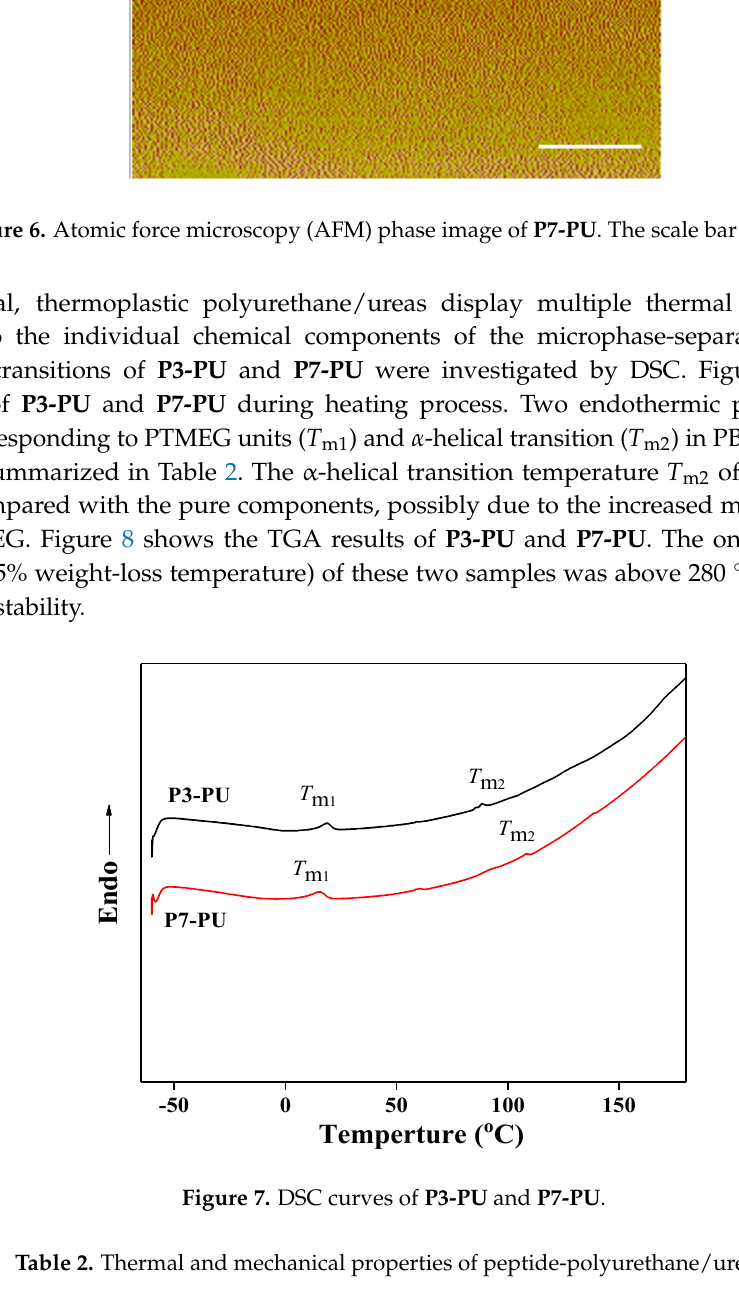
Figure 5. Wide angle X-ray diffraction (WAXD) profiles of P3-PU and P7-PU .